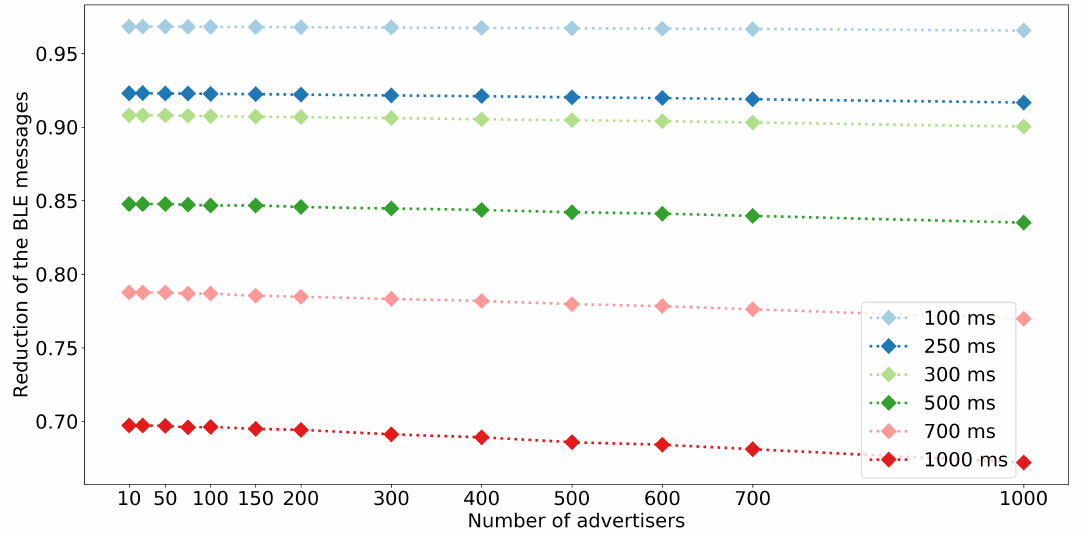
Figure 7. Median of the reduction of the number of BLE messages exchanged in continuous and intermittent mode for various advertisement intervals and network sizes. The reduction equals 1 minus ratio of ADV, SCAN_REQ and SCAN_RESP messages in intermittent mode versus the ADV messages in continuous